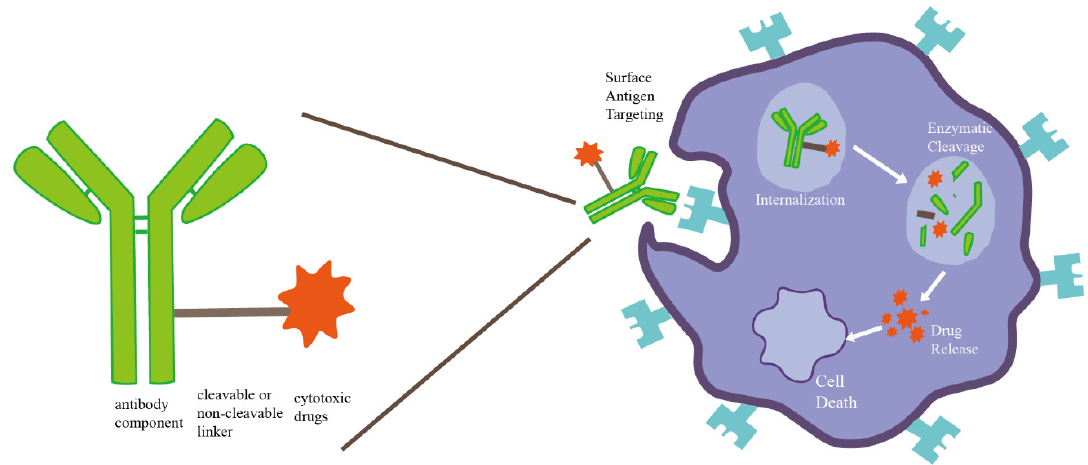
Figure 2. Schematic diagram of ADC composition structure and drug mechanism.